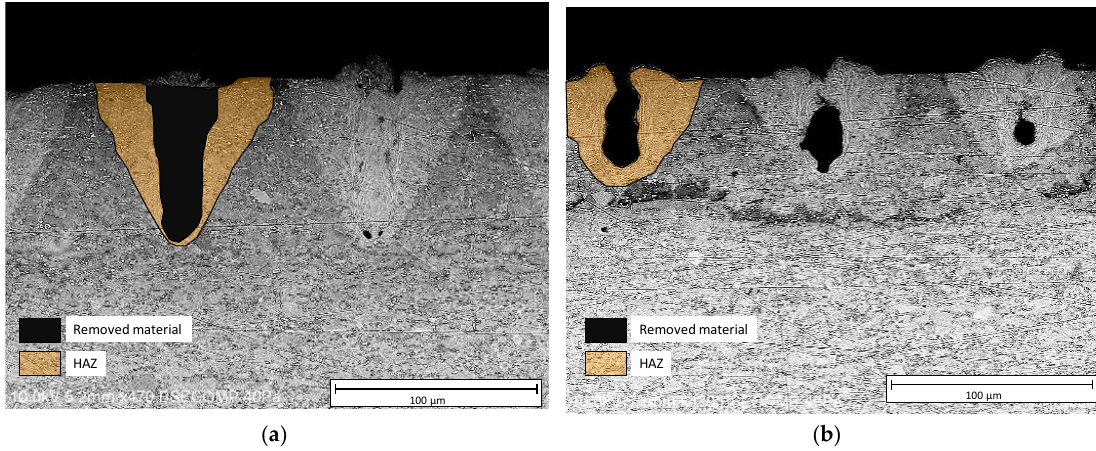
Figure 3. Heat-affected zone of textured tracks ( a ) 50 mm/s; ( b ) 75 mm/s. Figure 3. Heat-a ff ected zone of textured tracks ( a ) 50 mm / s; ( b ) 75 mm / s. Coatings 2019 , y , x FOR PEER REVIEW